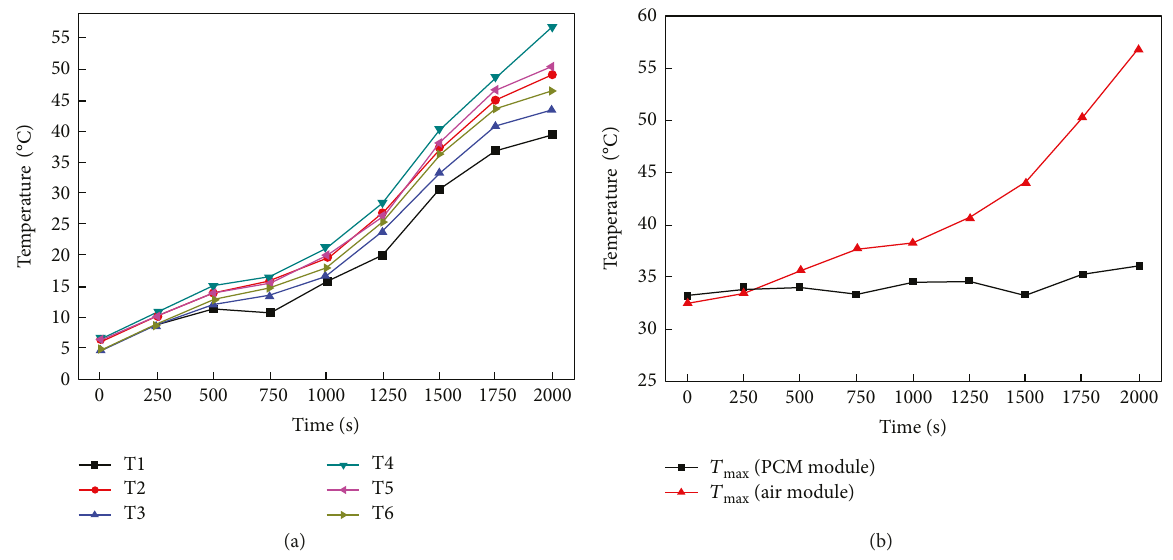
Figure 10: Pack testing results on the fl at ground. (a) Temperature curve of the air-cooled module. (b) The T between the air cooling module and PCM cooling module. ( T